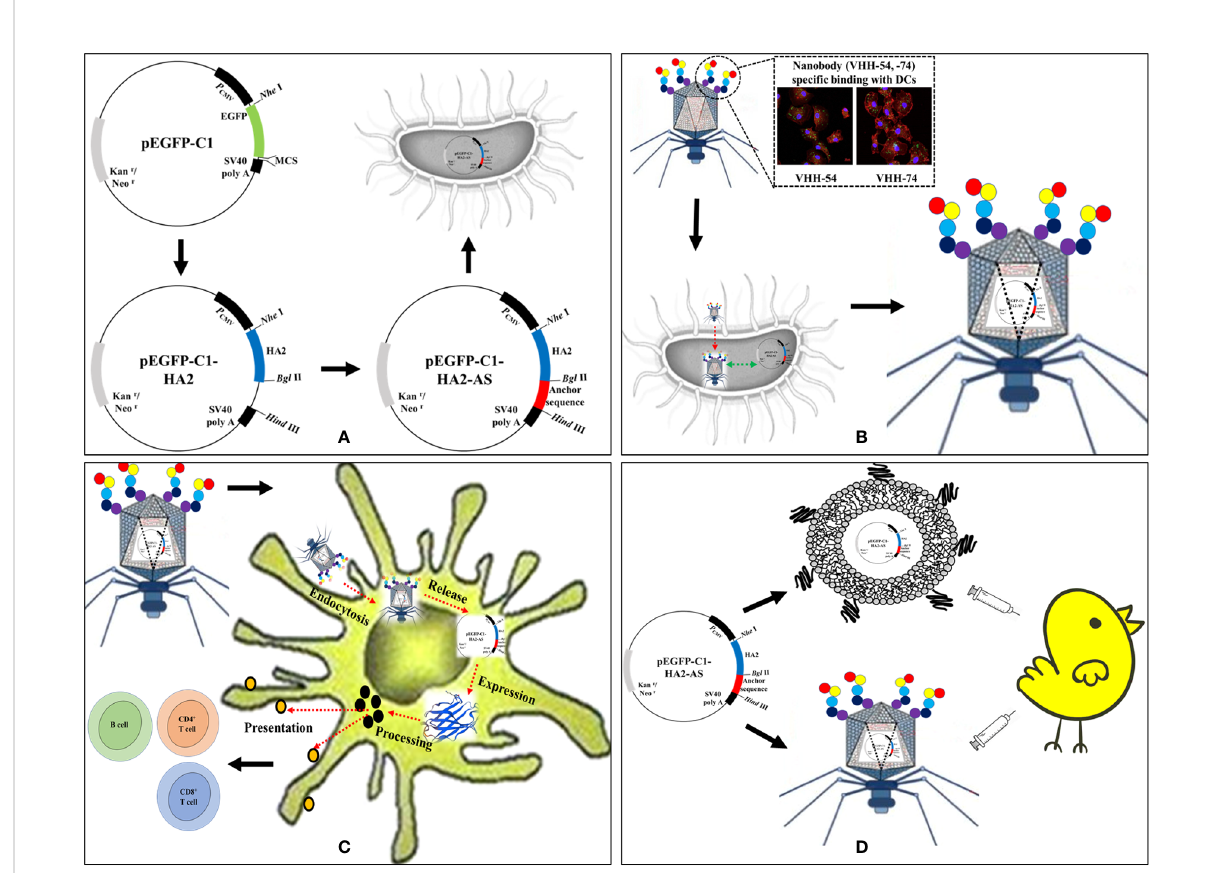
FIGURE 1 Schematic of AIV HA2 DNA vaccine delivered by dendritic cell (DC)-targeting phages. (A) Construction of eukaryotic expression plasmids containing the AIV HA2 gene and anchor sequence (AS). (B) DC-targeting phages encapsulate pEGFP-C1-HA2-AS plasmid during the reproduction process in Escherichia coli BL21. (C) DC-targeting phages deliver pEGFP-C1-HA2-AS plasmid into DCs and activate HA2 protein expression. (D) Immunogenicity evaluation of HA2 DNA vaccine in speci fi ed pathogen-free (SPF) chicken delivered by Lipofectin and DC- targeting